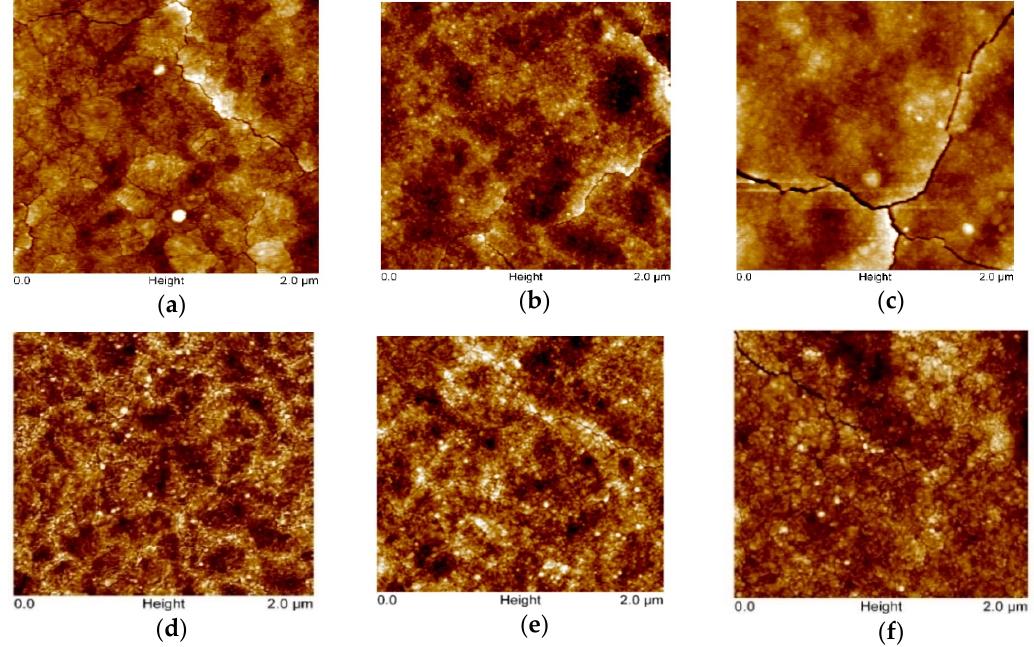
Figure 2. AFM images of TiO 2 thin films deposited from different solution concentrations and cycle numbers. TiO 2 thin films deposited from 0.1 M solution with the number of spray cycles: ( a ) 2, ( b ) 6, and ( c ) 15. TiO 2 thin films deposited from 0.2 M solution with the number of spray cycles: ( d ) 2, ( e ) 6, and ( f ) 15.